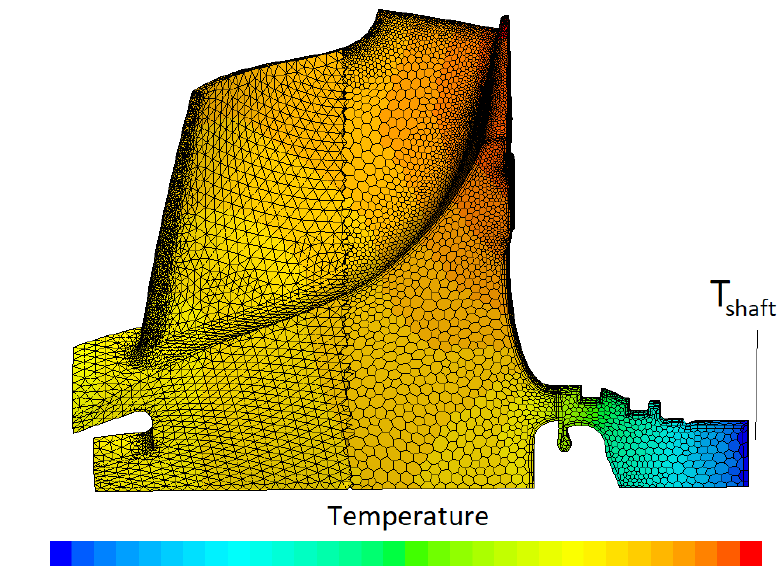
Figure 7. Tetrahedrals (CSM, left ), polyhedrals (CHT, right ).